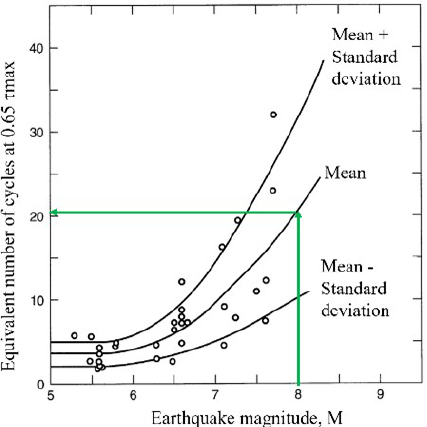
Figure 14. Equivalent number of uniform cyclic loading N eq for different seismic magnitudes (Martin et al., 1975). Table 4. Safety factor against liquefaction.